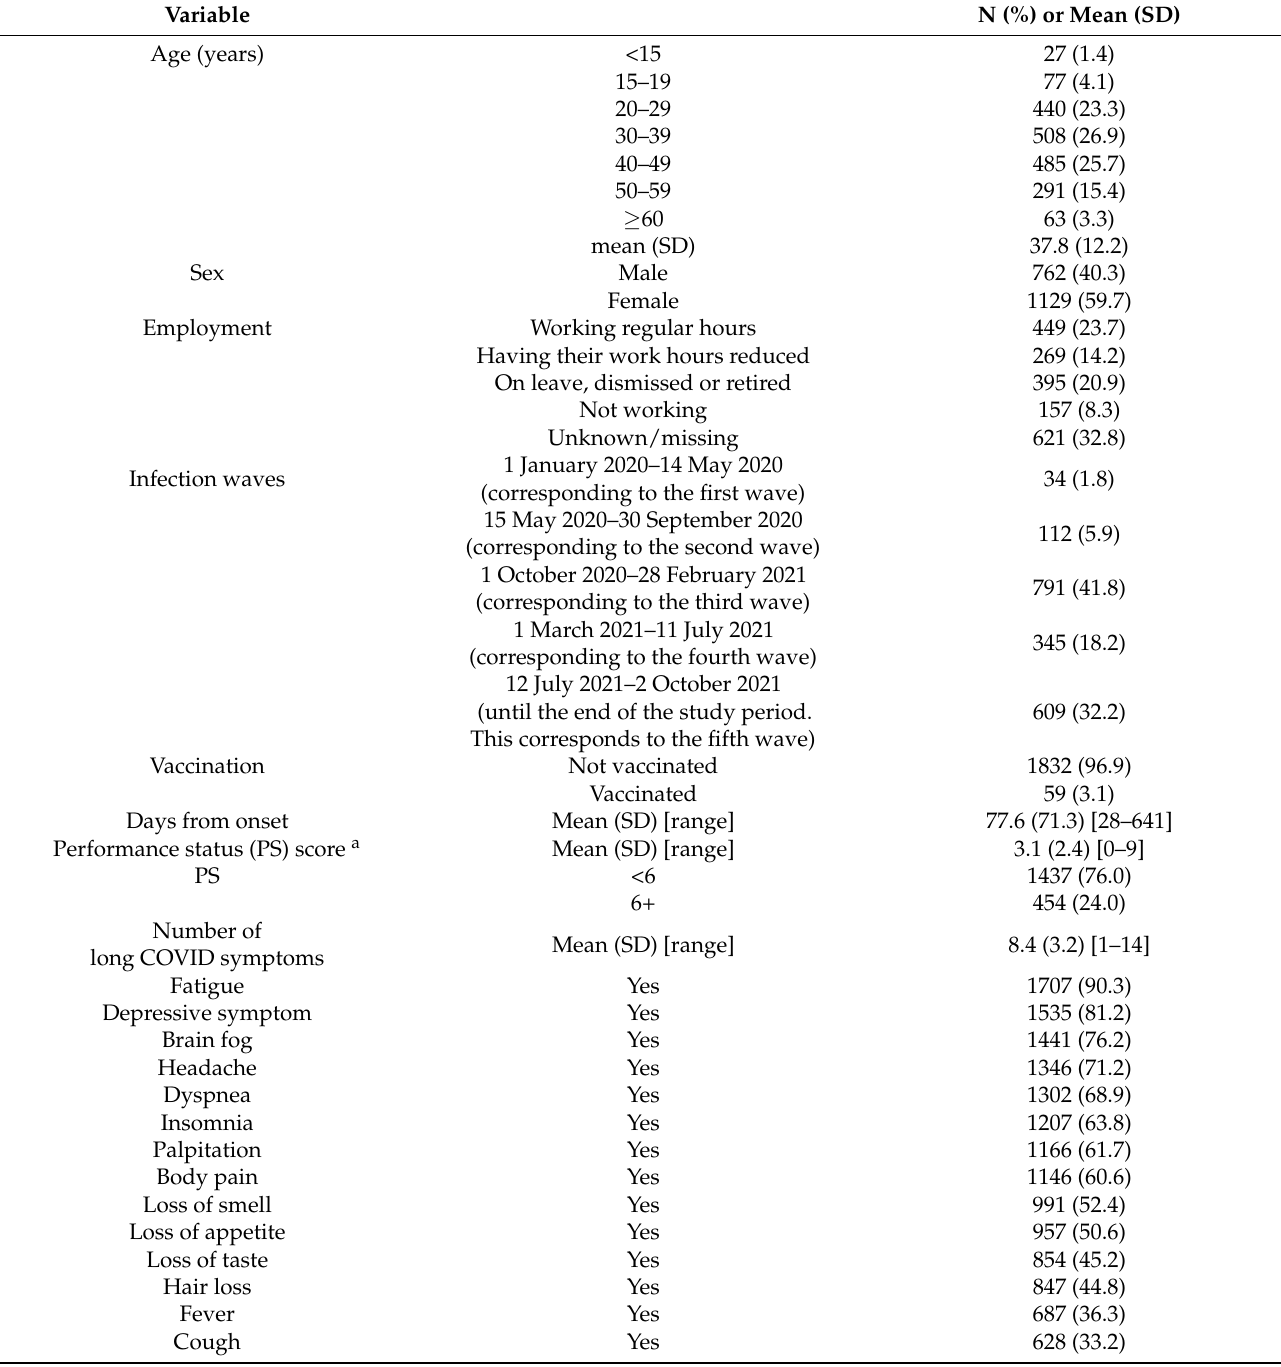
Table 1. Demographic characteristics of the patients who participated in this study ( n =